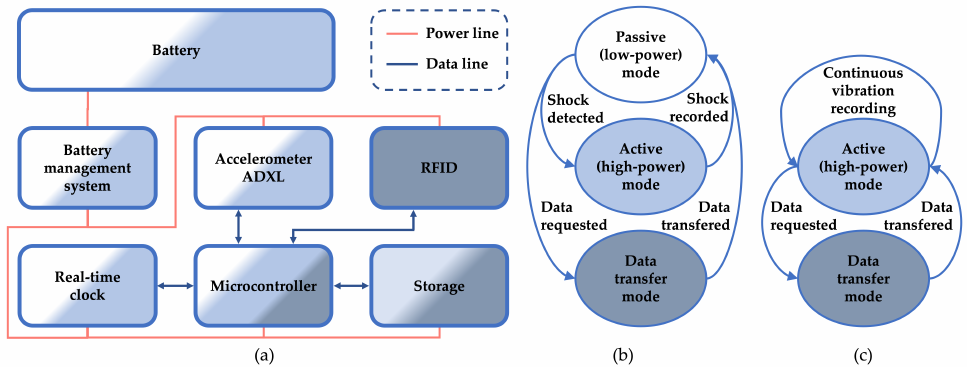
Figure 2. Smart Sticker device block diagram ( a ) used for: shock detection ( b ); continuous vibration recording ( c